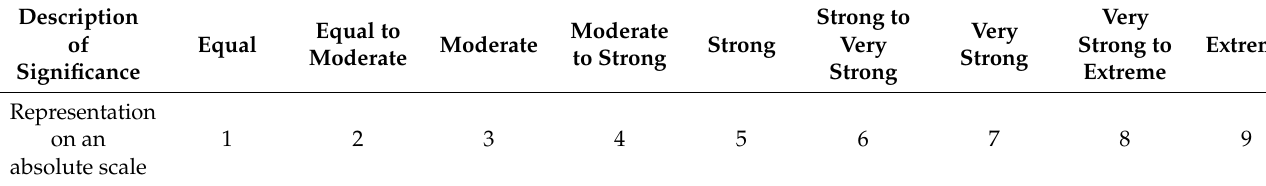
Table 8. Scale for the SWOT factor